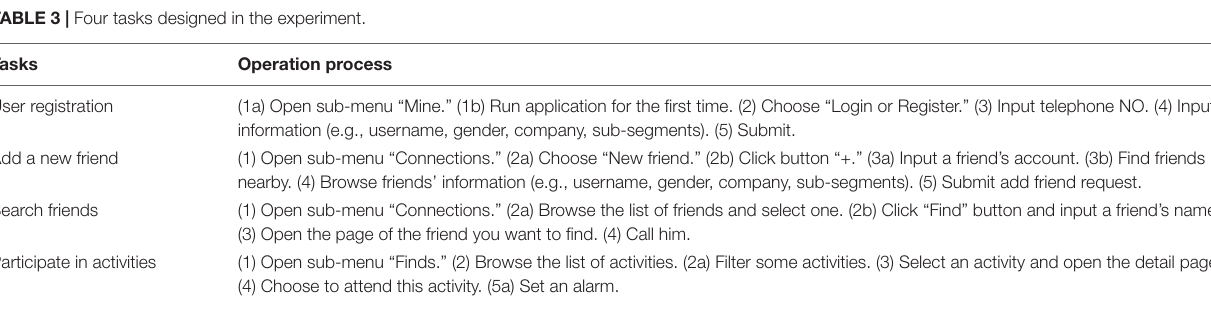
TABLE 3 | Four tasks designed in the